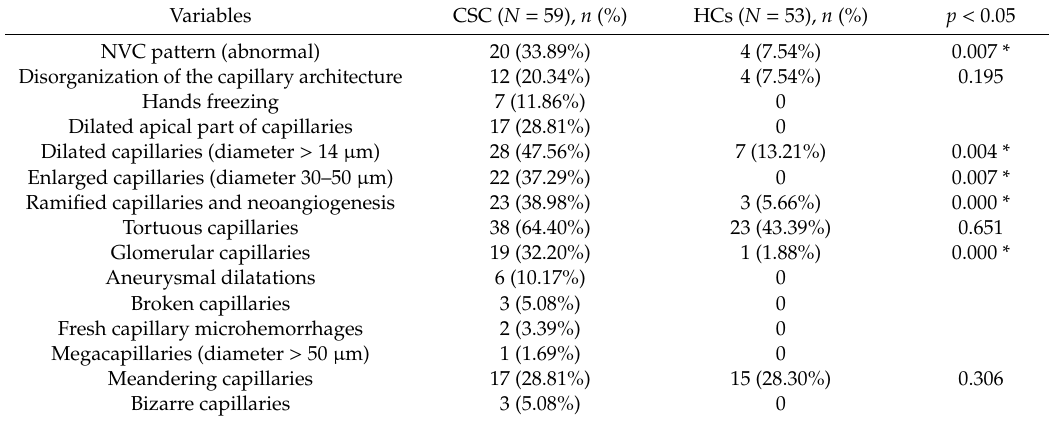
Table 2. Comparison of NVC parameters in central serous chorioretinopathy (CSC) patients and healthy controls (HCs).